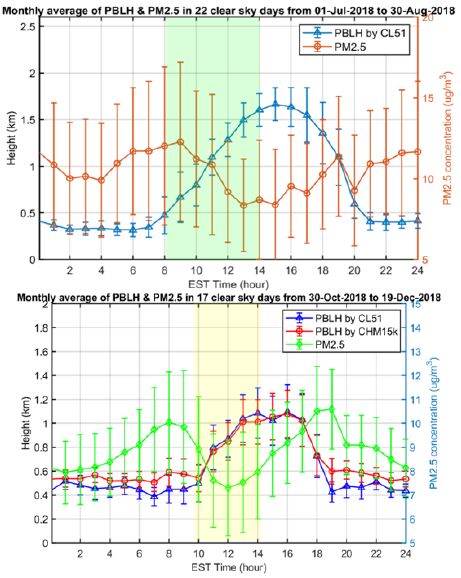
Figure 3. Inverse relationship exhibited between surface PM2.5 and PBL height during morning transition. (a) The diurnal averaged PBLHs measured by CL51 (no CHM15k data during summer) and the diurnal averaged PM2.5 in summer. (b) The diurnal averaged